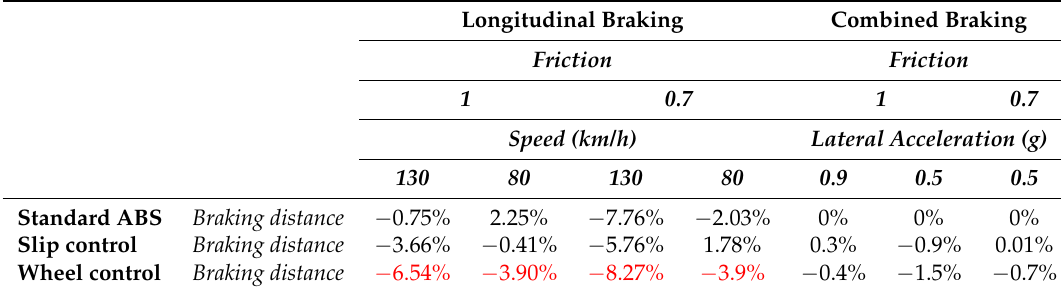
Table 3. Test results about braking distance performance.